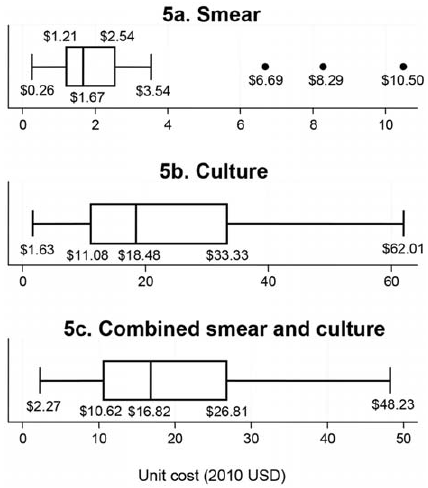
Figure 5. Summary of estimates of the three types of tests. (1) In each boxplot, dots represent outliers which are beyond the interval of (Q1–1.5*IQR, Q3 + 1.5*IQR): Q1 is the 25 th percentile, Q3 is the 75 th percentile, IQR is the interquartile range (75%–25%). (2) The five values listed beside each boxplot represent upper adjacent value (maximum value after excluding outliers), 75 th percentile, median (50%), 25 th percentile, and lower adjacent value (minimum value after excluding outliers), respectively. For instance, in Plot 5a, for estimates of smear test alone, $ 3.54 (upper adjacent value) is the maximum value excluding three outliers. $ 2.54 is the value at the75 th percentile. $ 1.67 is thevalue of